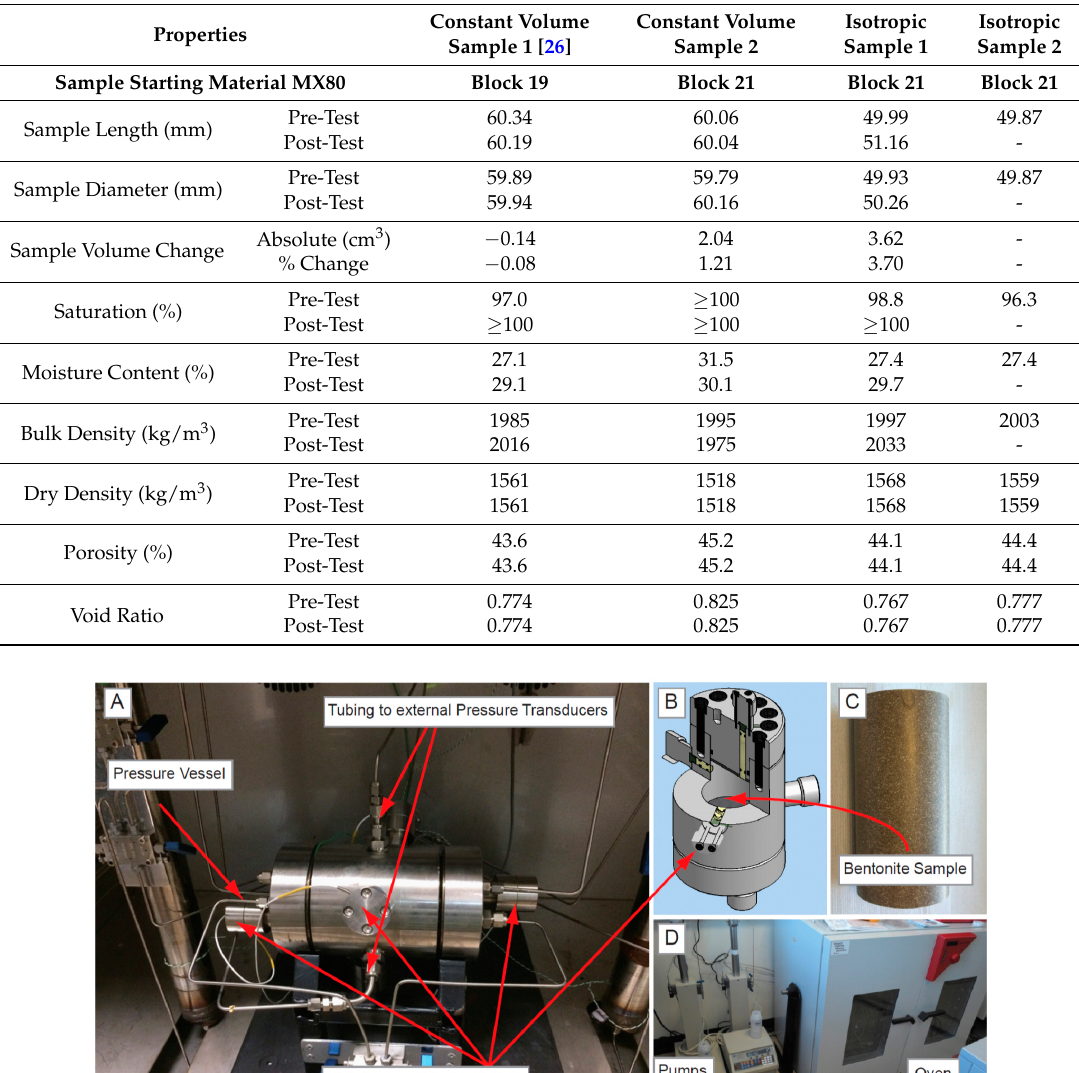
Table 1. Sample parameters and geotechnical properties of the bentonite used in each of the experiments presented in this study; before and after the testing phase. Post-test measurements could not be obtained for the second isotropic (ISO-2) sample because the apparatus failed during the 200 ◦ C test stage, contaminating the sample with confining fluid.